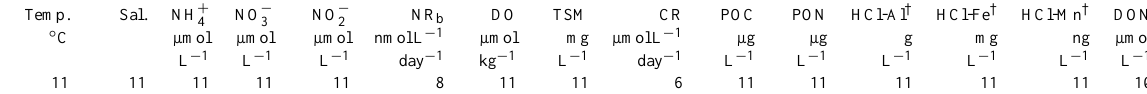
Table 2d. Correlation matrix of field-surveyed data among all regions of the Chang Jiang River plume.